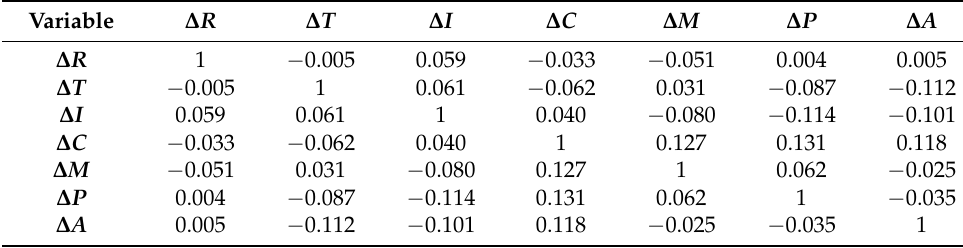
Table 4. Correlation analysis of the variables